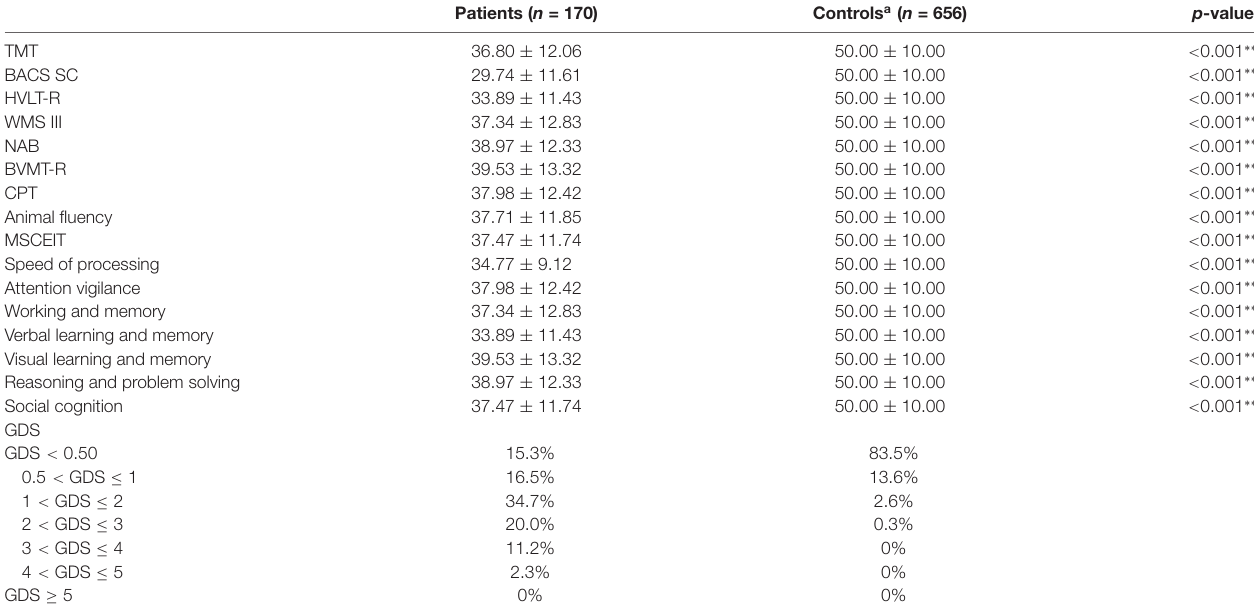
TABLE 2 | Comparing the cognitive scores from the MATRICS Consensus Cognitive Battery (MCCB) in early-stage schizophrenia and healthy adults. Patients ( n = 170)